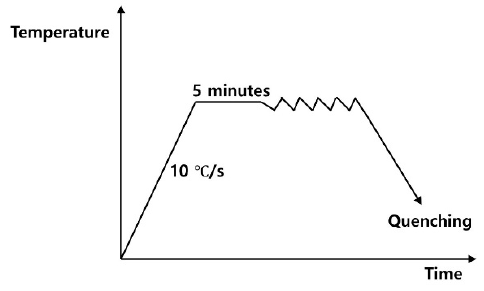
Figure 1. Compression test. ( a ) Mounted specimen and ( b ) hot compression process.